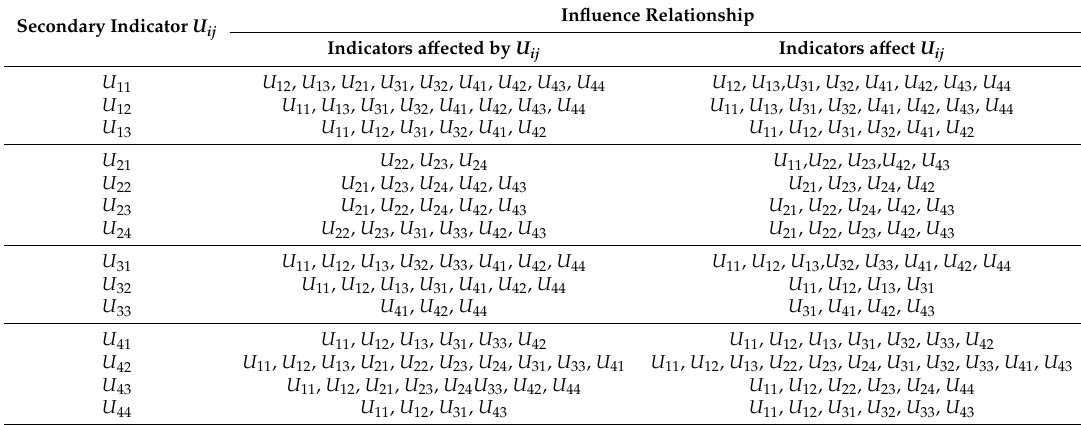
Table A1. Influence relationship among secondary